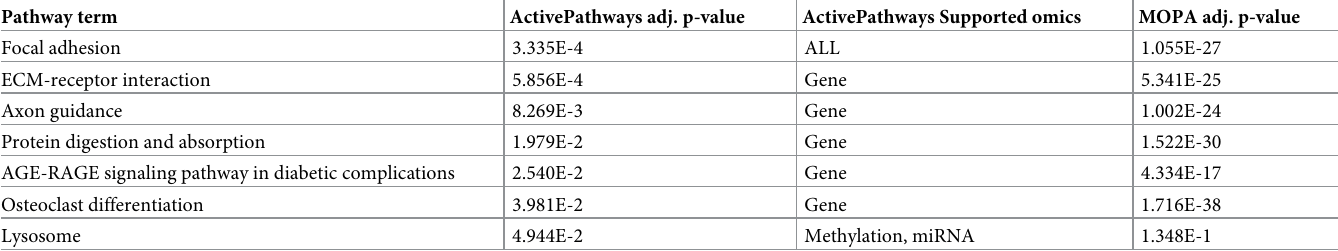
Table 4. Comparison btween ActivePathways and